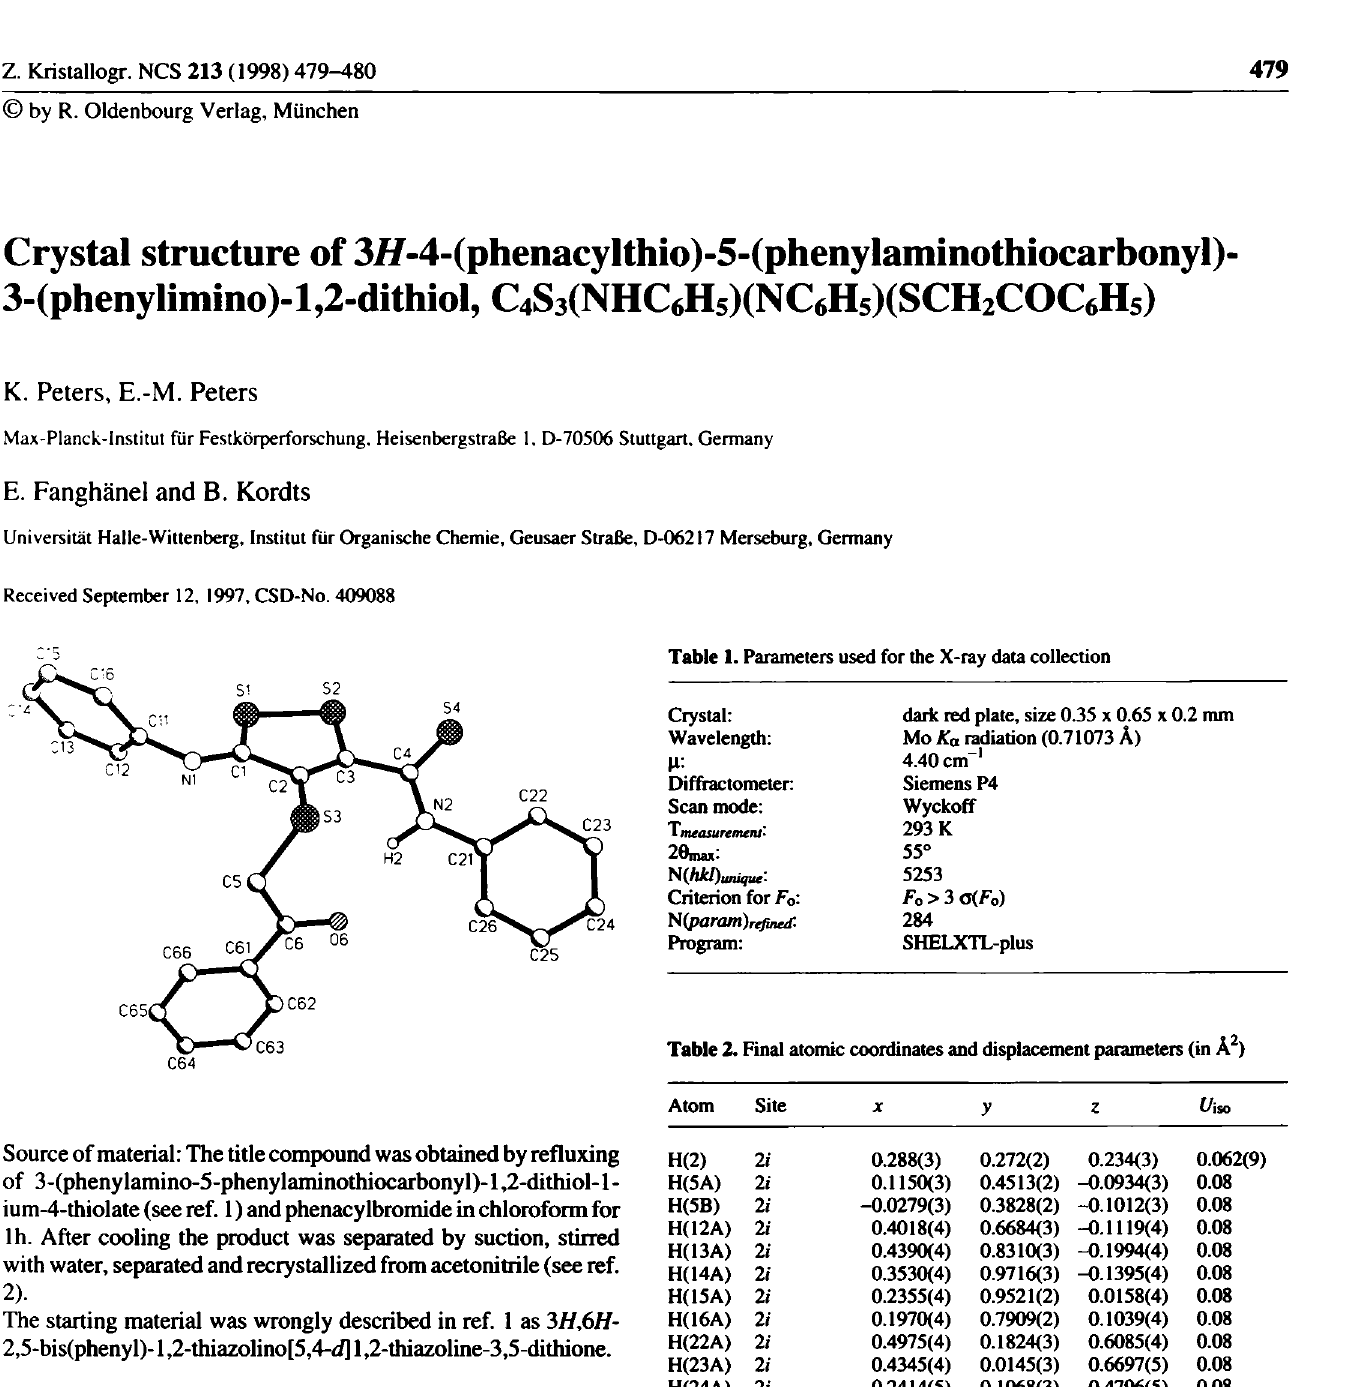
Table 2. Final atomic coordinates and displacement parameters (in Â^)